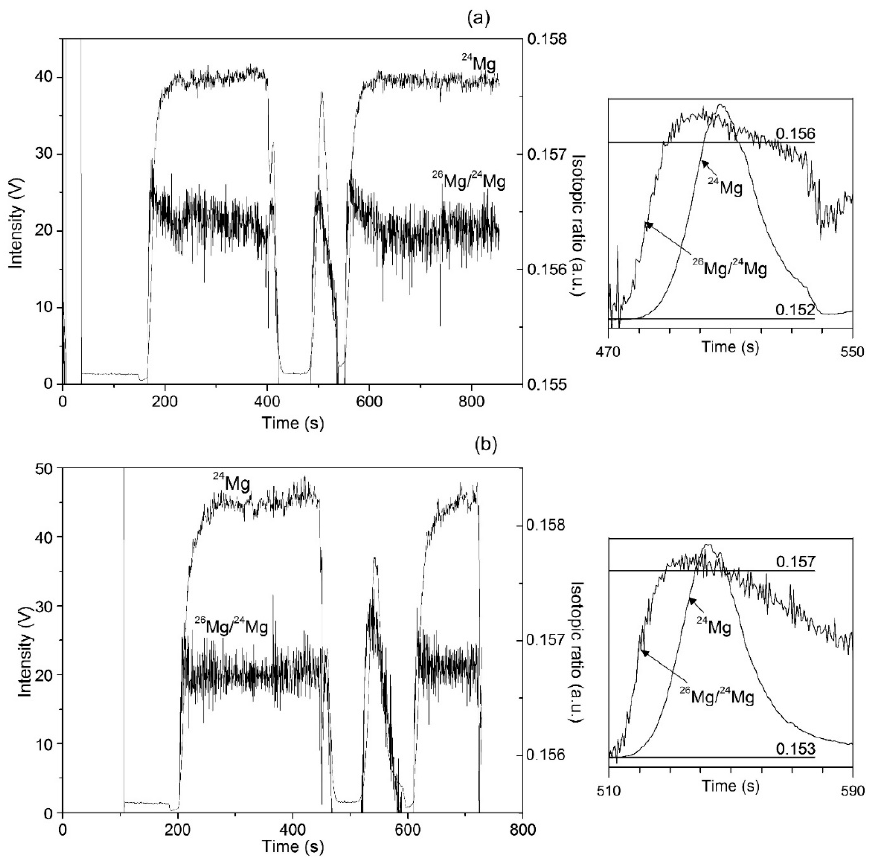
Figure 1. Mg-isotope analysis in chlorophyll-a from garden cress ( a ) and from maize ( b ). Left panel shows multiple collector inductively coupled plasma-mass spectrometry (MC ICP-MS) measurements during chromatographic run (the flat-top peaks are from DSM-3 standard and the signal in the middle corresponds to Mg elution from cation exchange column). Isotopic ratio 26 Mg / 24 Mg during chromatographic peak elution is presented for the two plants in the right panel.